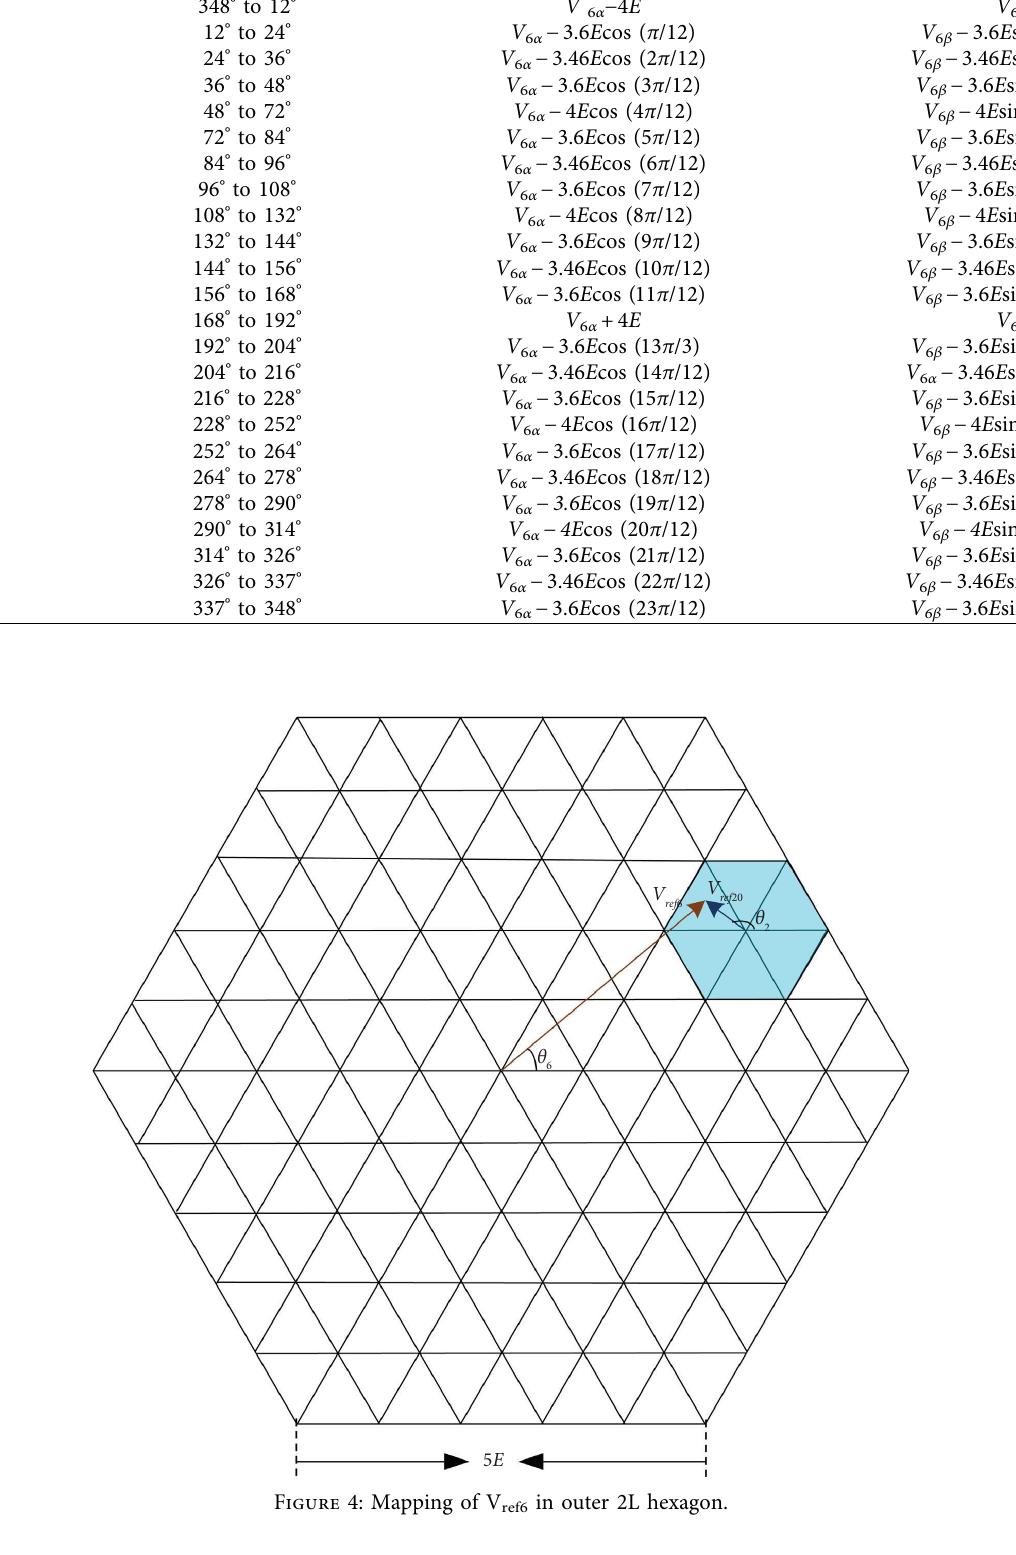
Table 4: Selection of outer 2L hexagons from 6L SVD and mapping of V Hexagon No